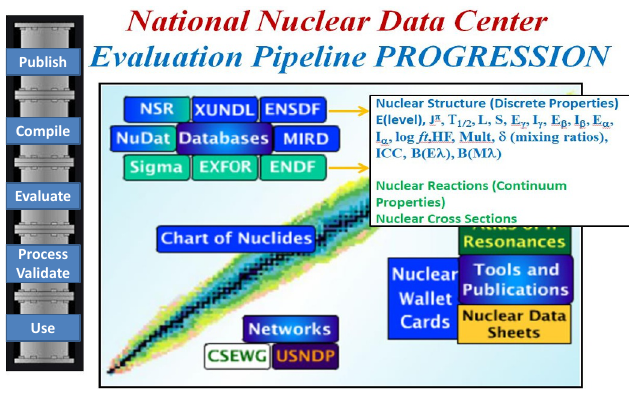
Figure 2. Main portal page of the NNDC internet site (https: // www.nndc.bnl.gov / ) together with the "Evaluation Pipeline" drawing (on the left side) which illustrates the way the nuclear structure data evaluation is conducted as described in the